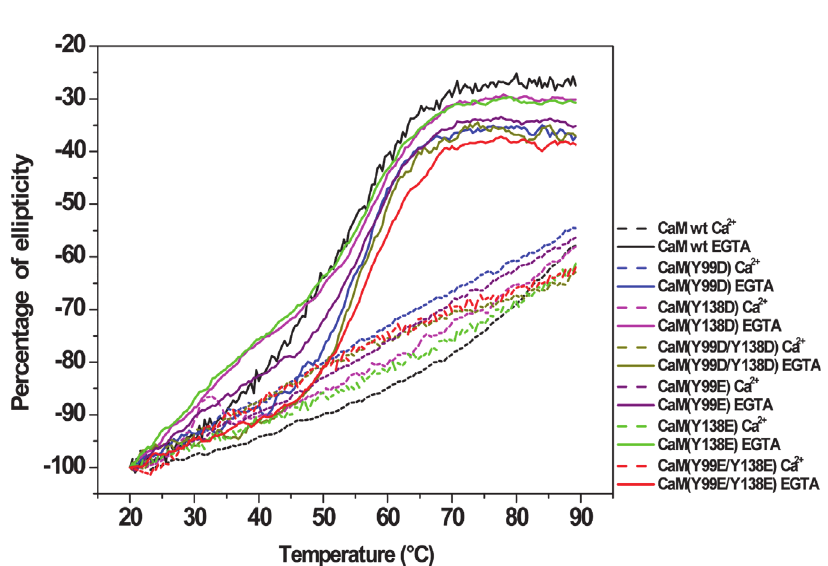
Fig 4. Thermal stability of the different CaM species in the absence and presence of Ca 2+ . The plots present the decrease in the CD signal at 222 nm, expressed as percentage of the ellipticity at 20°C, for wild type ( wt ) and the single and double Y/D and Y/E CaM mutants (12 μ M) in 20 mM Tris-HCl (pH 7.5), 0.1 M KCl, in the presence of 1 mM EGTA ( solid lines ) and 1 mM CaCl 2 ( dashed lines ) as described in Materials and